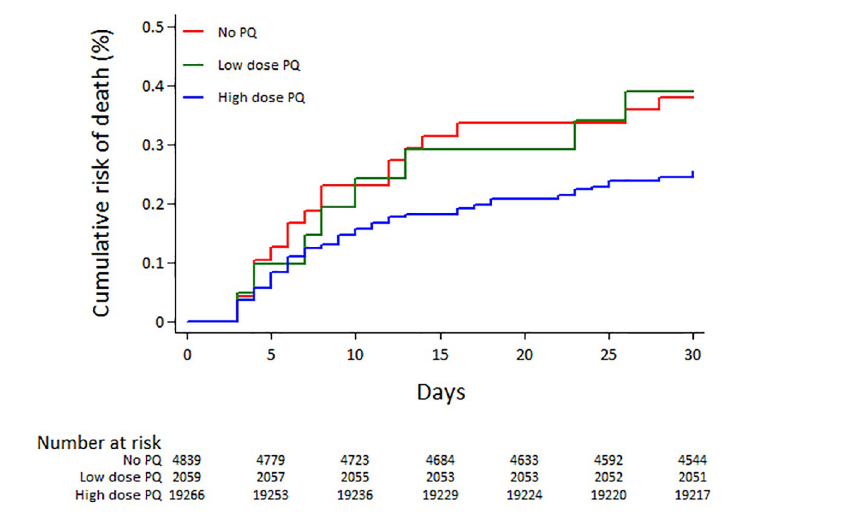
Fig 4. Risk of all cause death by primaquine (PQ)